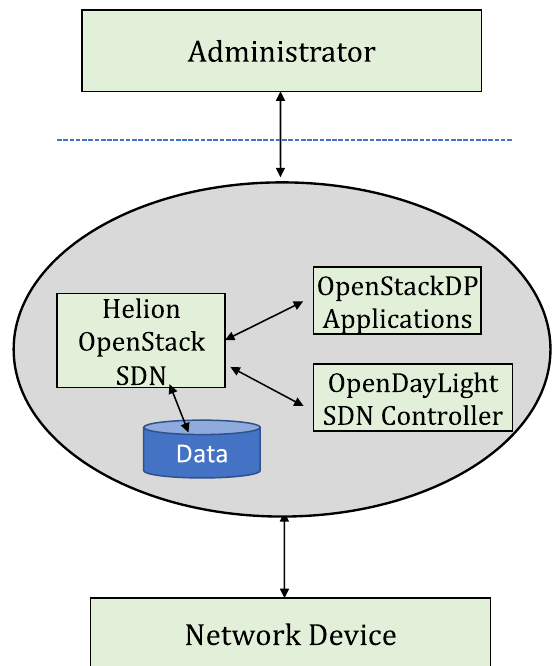
Fig. 36 DFD for OpenStackDP Framework